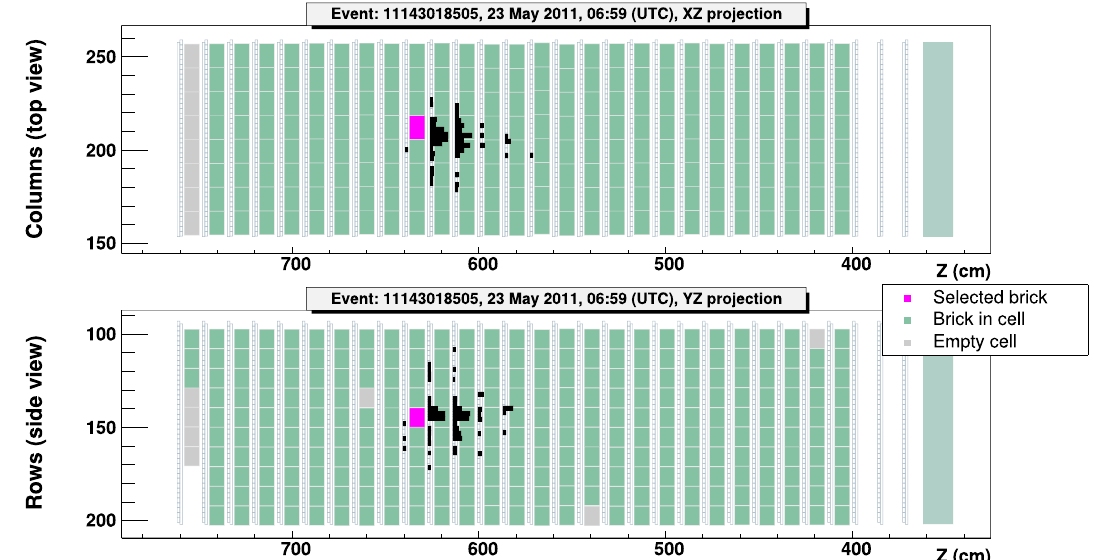
Fig. 3 Electronic detector display of the event. CNGS neutrinos travel from left to right. The angle between the neutrino direction and the Z-axis projected into the XY plane is 58 mrad. Black bars indicate TT hits over threshold and are proportional to the released energy. Pink